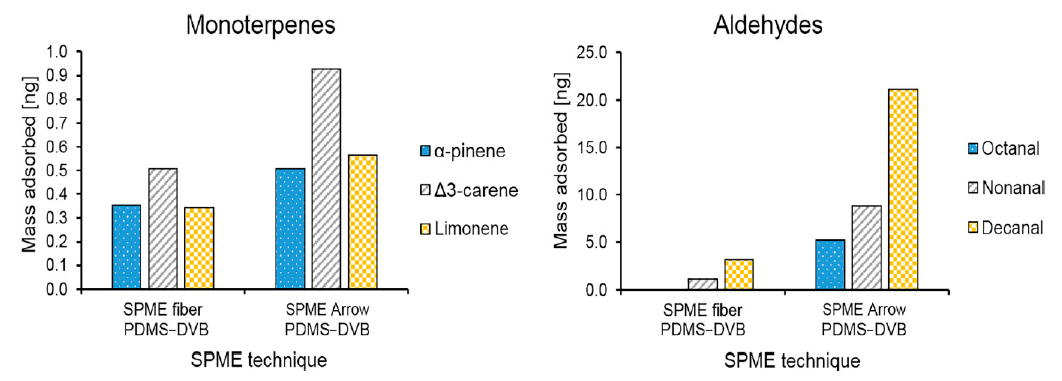
Figure 6. Comparison between the average mass of identified monoterpenes ( α -pinene, 13-carene, and limonene) and aldehydes (octanal, nonanal, and decanal) collected with different polydimethylsiloxane-divinylbenzene (PDMS-DVB) SPME devices (fiber and Arrow) from ambient air and measured by GC-MS. Figure reprinted with permission of Elsevier from Reference [48], 2019.